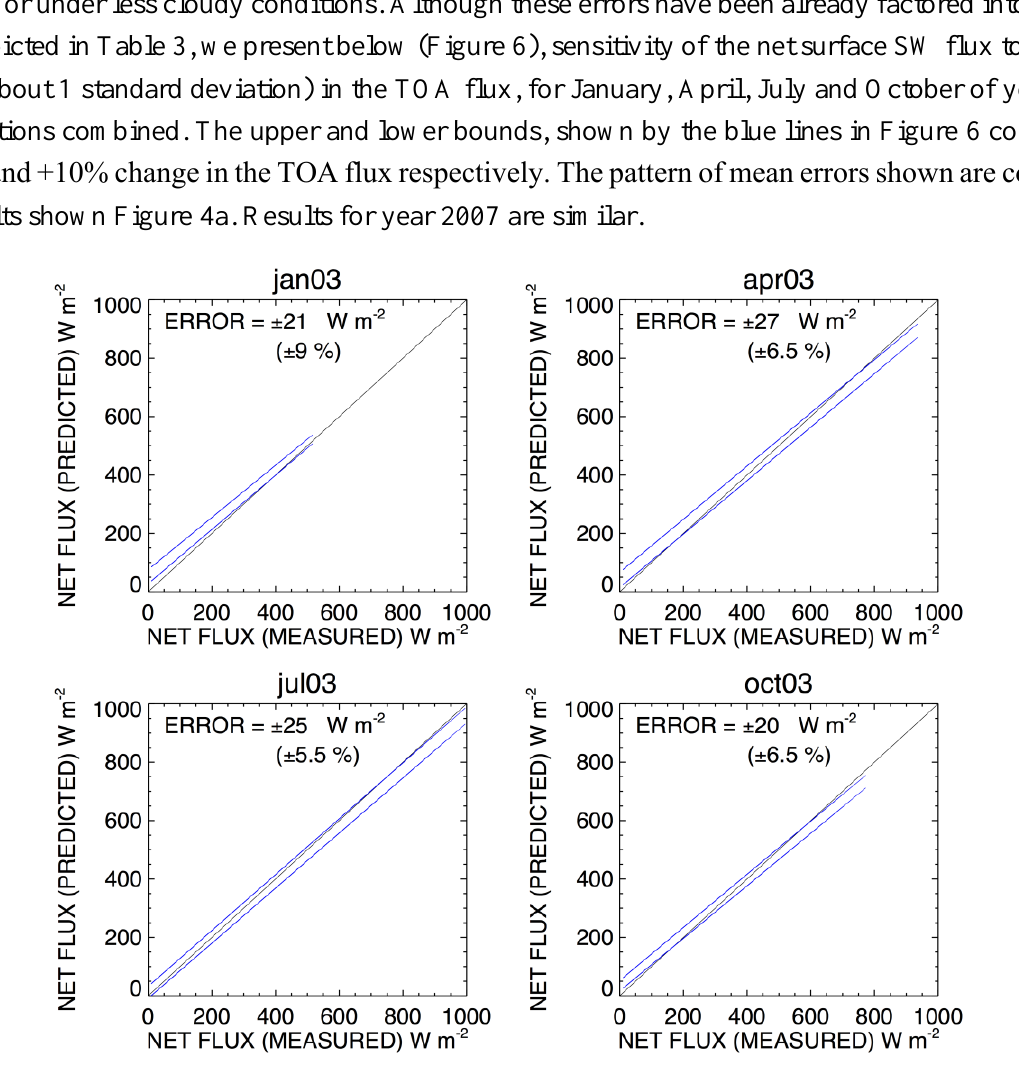
Figure 6. Sensitivity of net surface SW flux to TOA SW flux (±1σ) The blue lines show the bounds, with the lower bound corresponding to + 1 standard deviation change in the TOA flux and vice versa . The mean error and percentage are shown in the